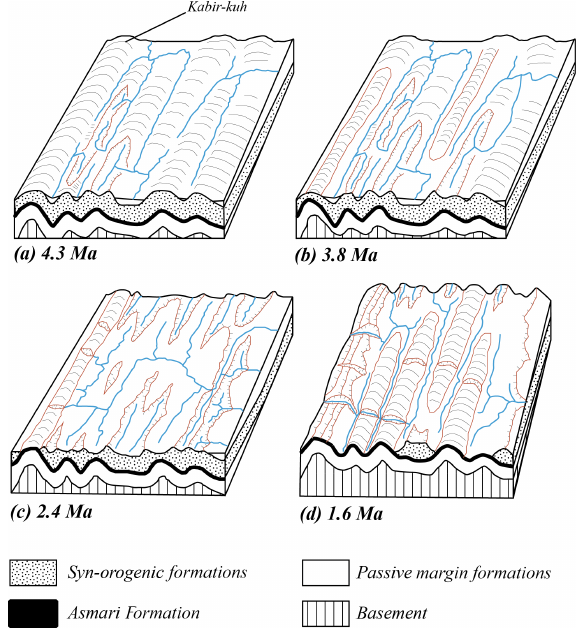
Figure 3. Evolution of the drainage network in the Zagros chain sector of the Kabir-kuh fold, according to the model by Oberlan- der (1985) and with the timing provided in the landscape evolution model by Tucker and Slingerland (1996). See the text for explana- tion of the four steps (modified from Oberlander,